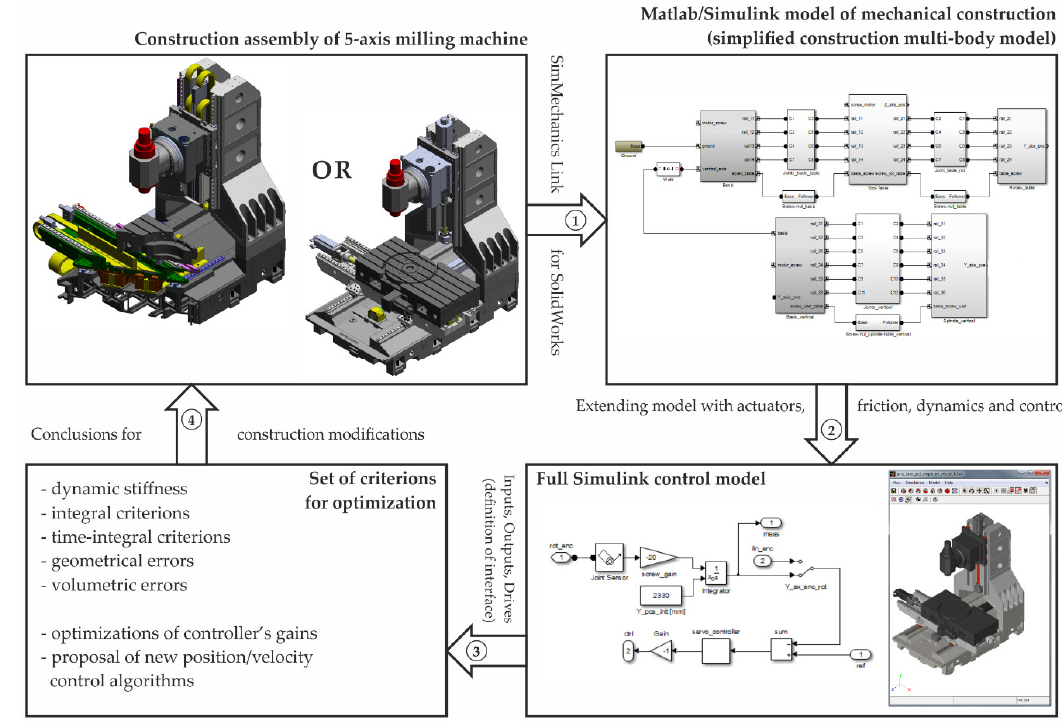
Figure 11. AVIA X-5 machining centre virtual optimization workflow.